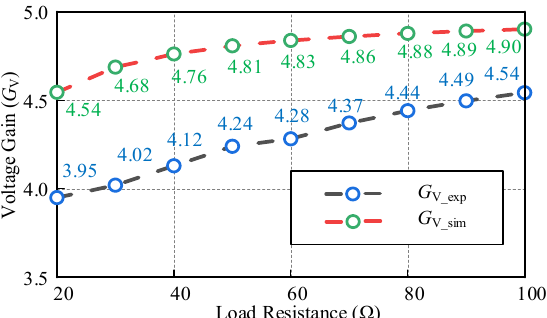
Figure 16. Experimental waveforms of U IN , I IN , U OUT , and I OUT .